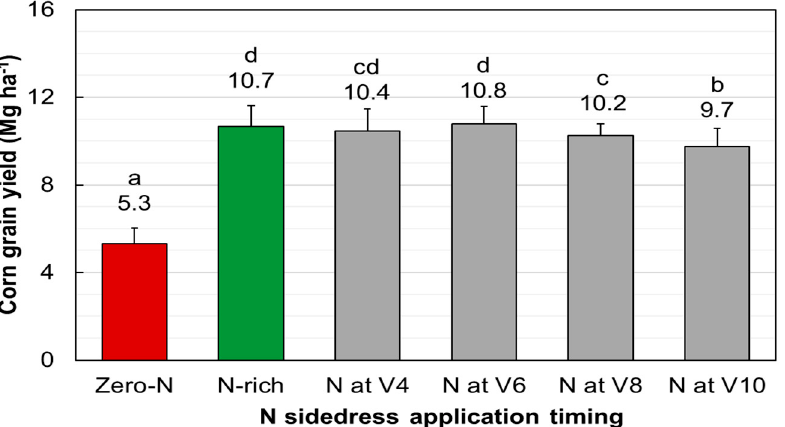
Figure 4. Corn grain dry matter yield as affected by N sidedress application treatments.